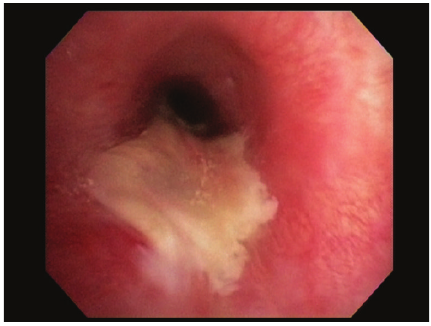
Figure 2: Endobronchial view of left main bronchus repair.